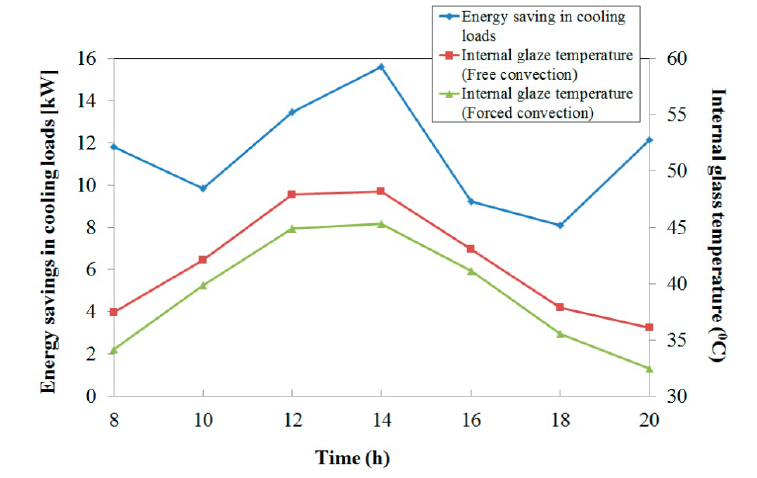
Figure 15. Internal glass temperature for free and forced convection ventilation systems and energy savings in cooling loads during a day